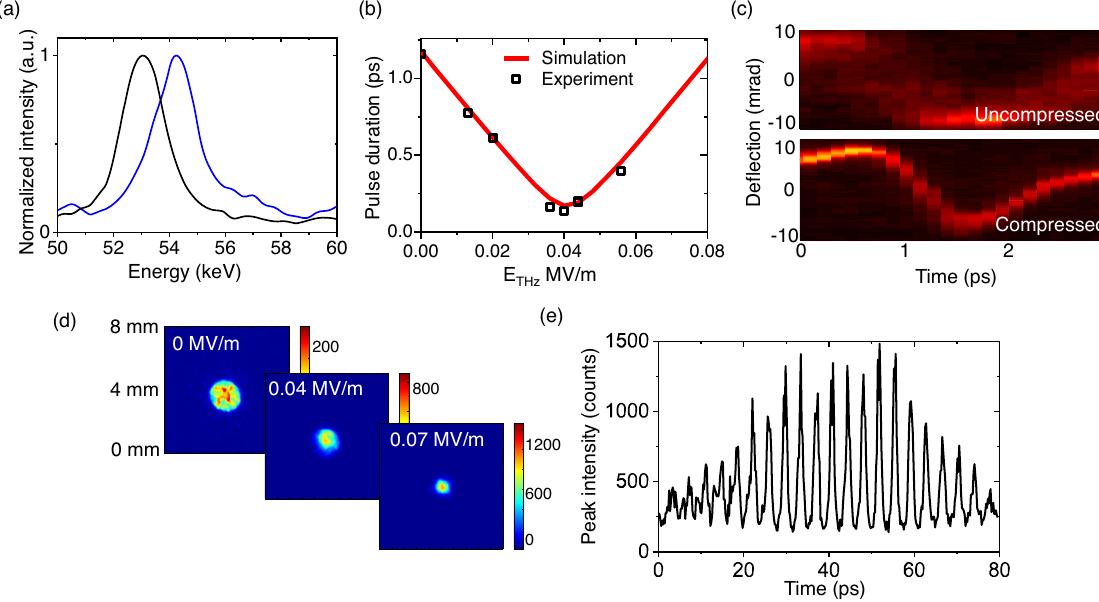
FIG. 3. DLW-based electron manipulation. (a) Measured electron energy spectra for the input beam (black curve) and accelerated beam (blue curve) in the acceleration mode. (b) Measured (hollow square) and simulated (red line) electron bunch length as a function of the applied THz field in compression mode. The simulation is performed with ASTRA with around 1 fC charge injected into the DLW. (c) Time-dependent deflection diagrams measured by varying the delay between the arrival time of the electron bunch and the deflecting THz pulse for initially uncompressed and compressed electron bunches. (d) Electron beam diameter as a function of the THz field strength in focusing condition. (e) Electron peak intensity change as a function of the THz-electron